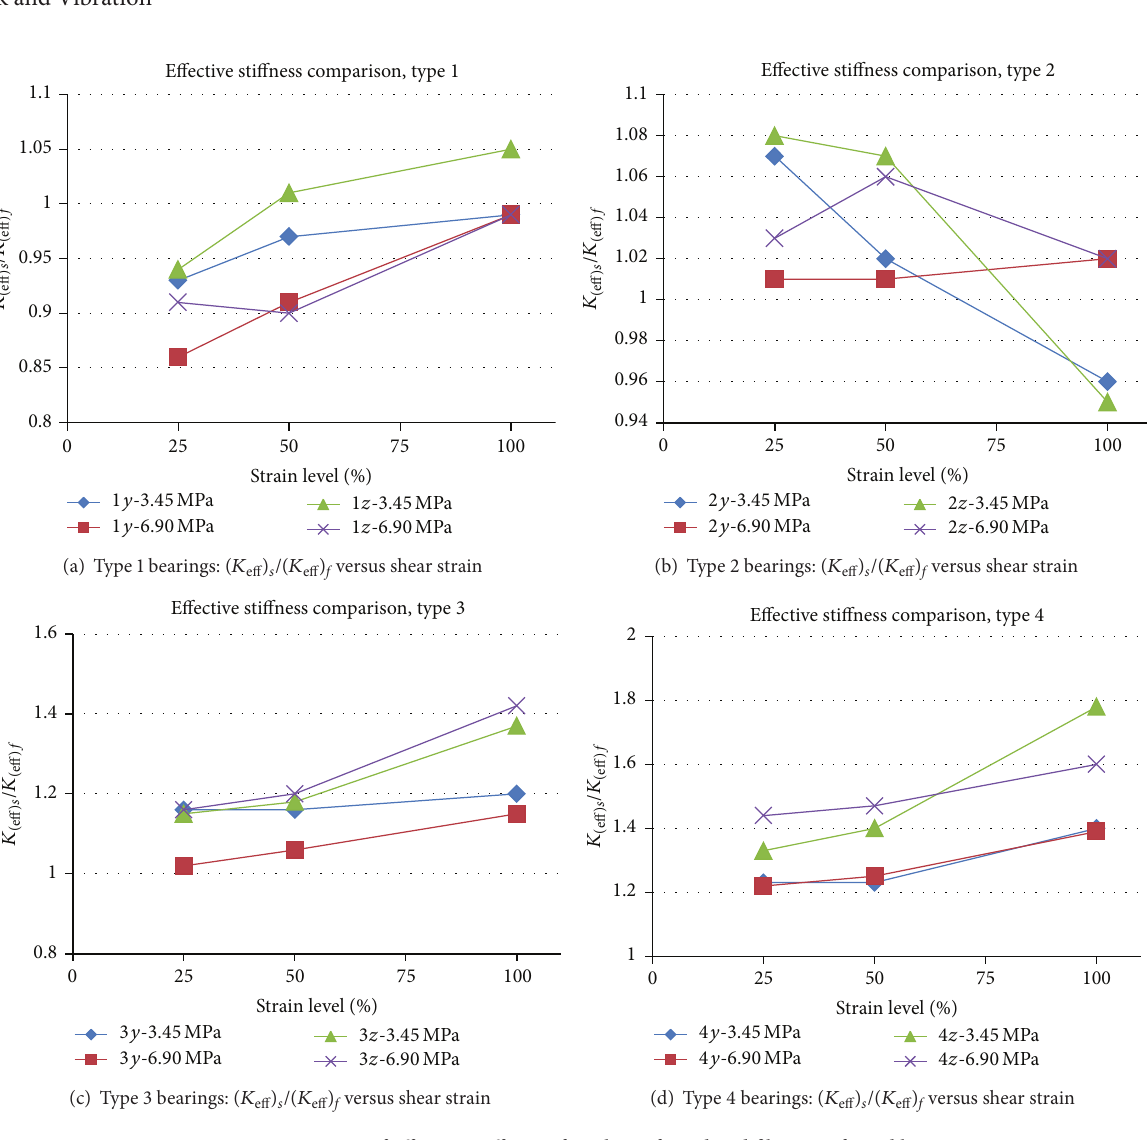
Figure 4: Comparison of effective stiffness of steel-reinforced and fiber-reinforced bearings.